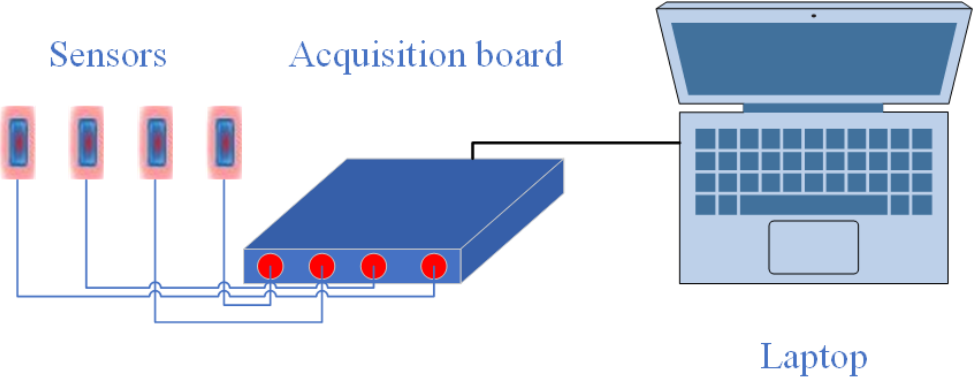
Figure 6. The acquisition and monitoring system.